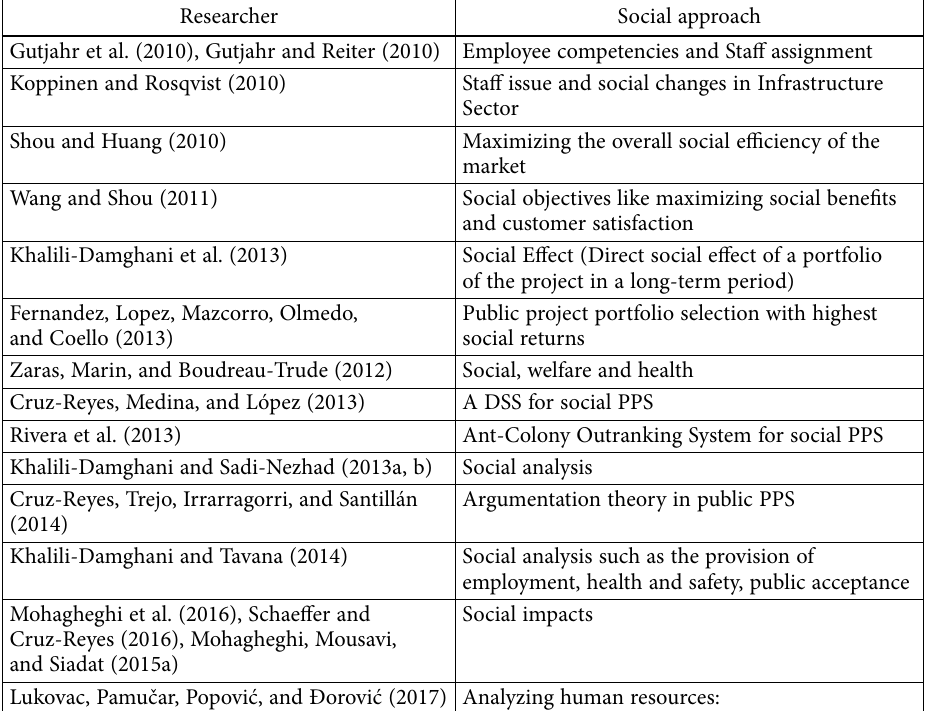
Table 6. Considering social aspects in PPS Researcher Social approach Staff issue and social changes in